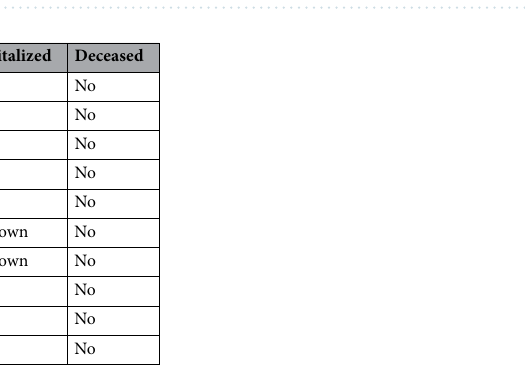
Table 2. Overview of confirmed COVID-19 cases in nursing home NH02. Order by the onset of